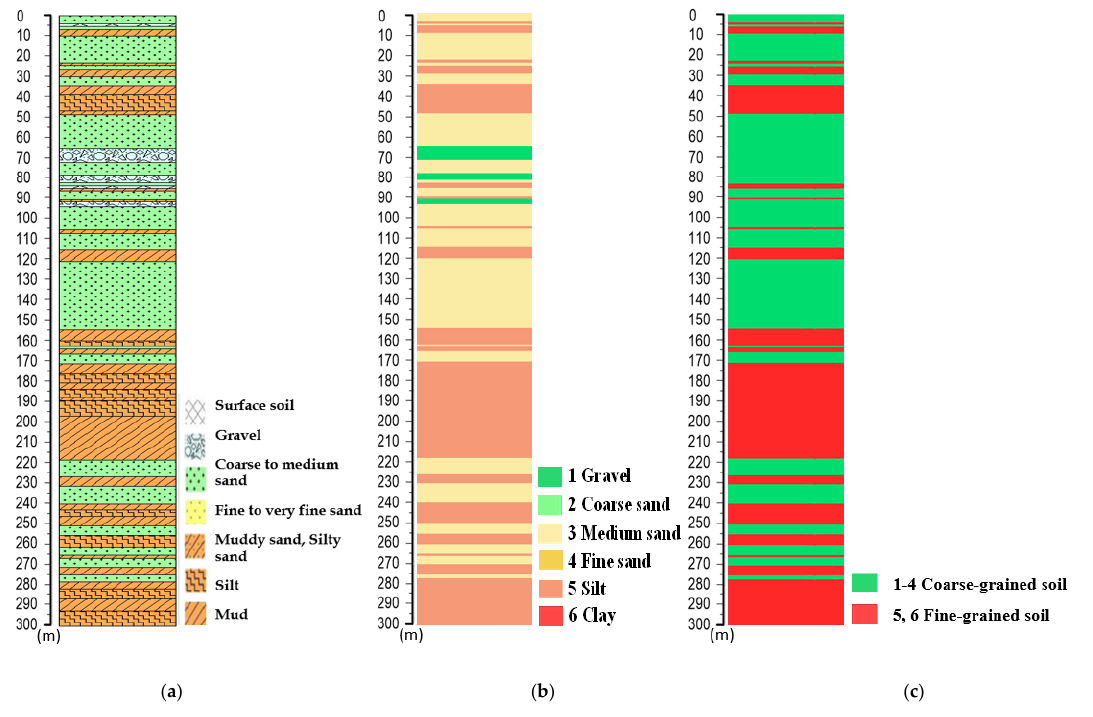
Figure 3. Examples of borehole logging data: ( a ) Water Resources Agency; ( b ) this study (six soil type); ( c ) this study (two main